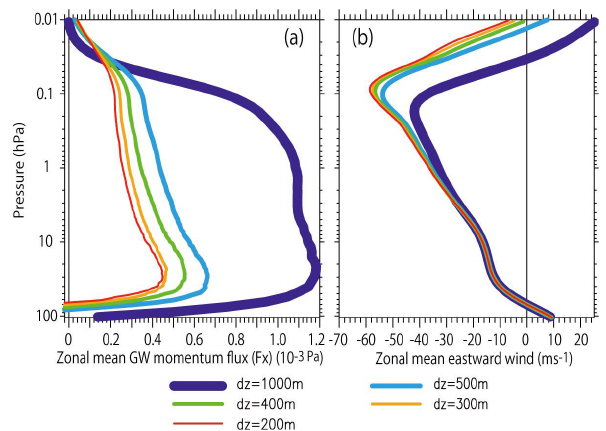
Figure 1. (a) Vertical profiles of the zonal mean net upward flux of the eastward momentum associated with the gravity wave compo- nent ( λ h < 950km) for each vertical resolution. (b) Similar to (a) but for the zonal mean eastward winds. Averages over 35–40 ◦ N from 00:00UT, 23 June, to 00:00UT, 27 June are